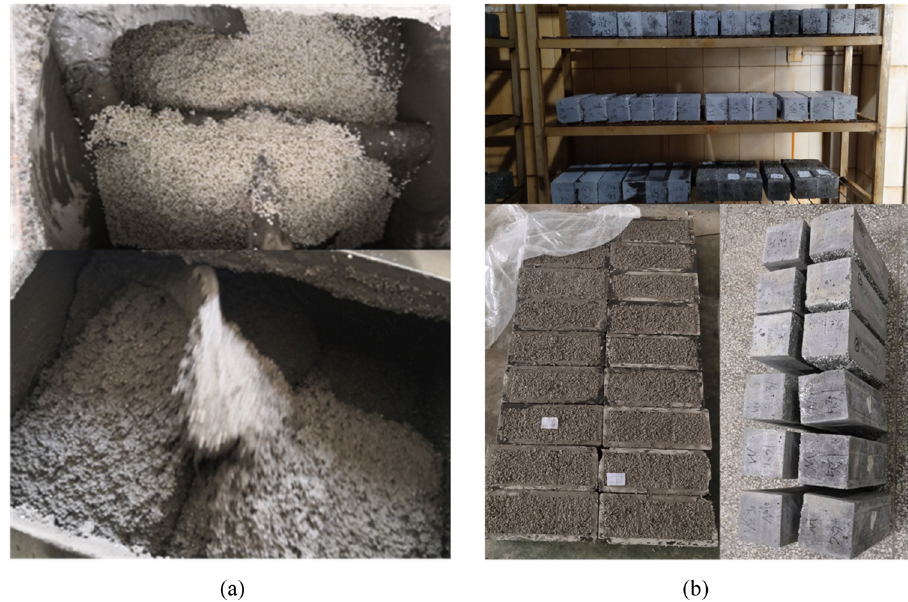
Figure 3: Manufacturing process of EPS concrete specimens: ( a ) concrete mixing and ( b ) specimens